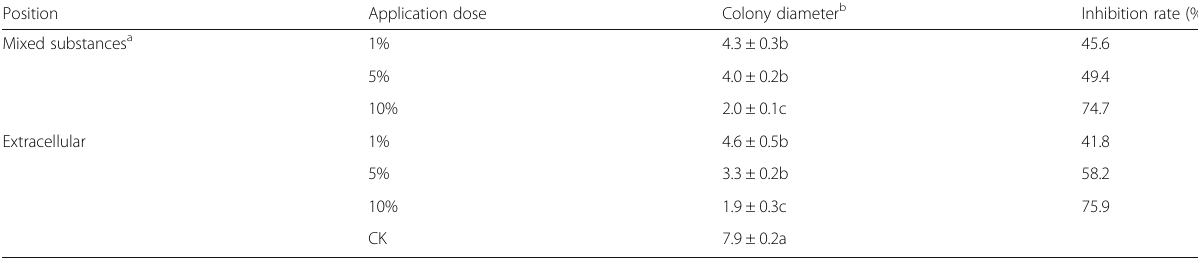
Table 3 Detection of production position of antifungi substances from BM21 against Fusarium graminearum